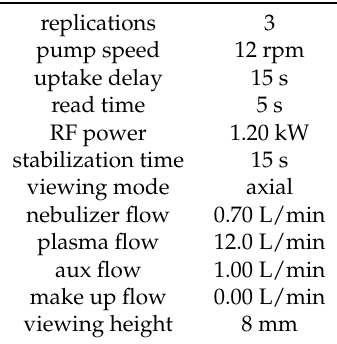
Table 1. Measurement parameters of the ICP-OES method for Au